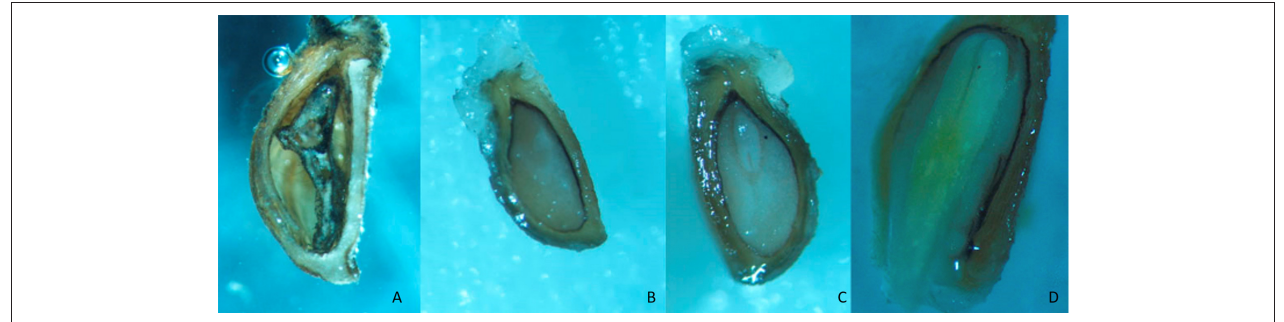
FIGURE 1 | Dissected Eryngium seeds empty (A) , embryoless (B) , with underdeveloped embryo (C) and fully developed embryo (D).